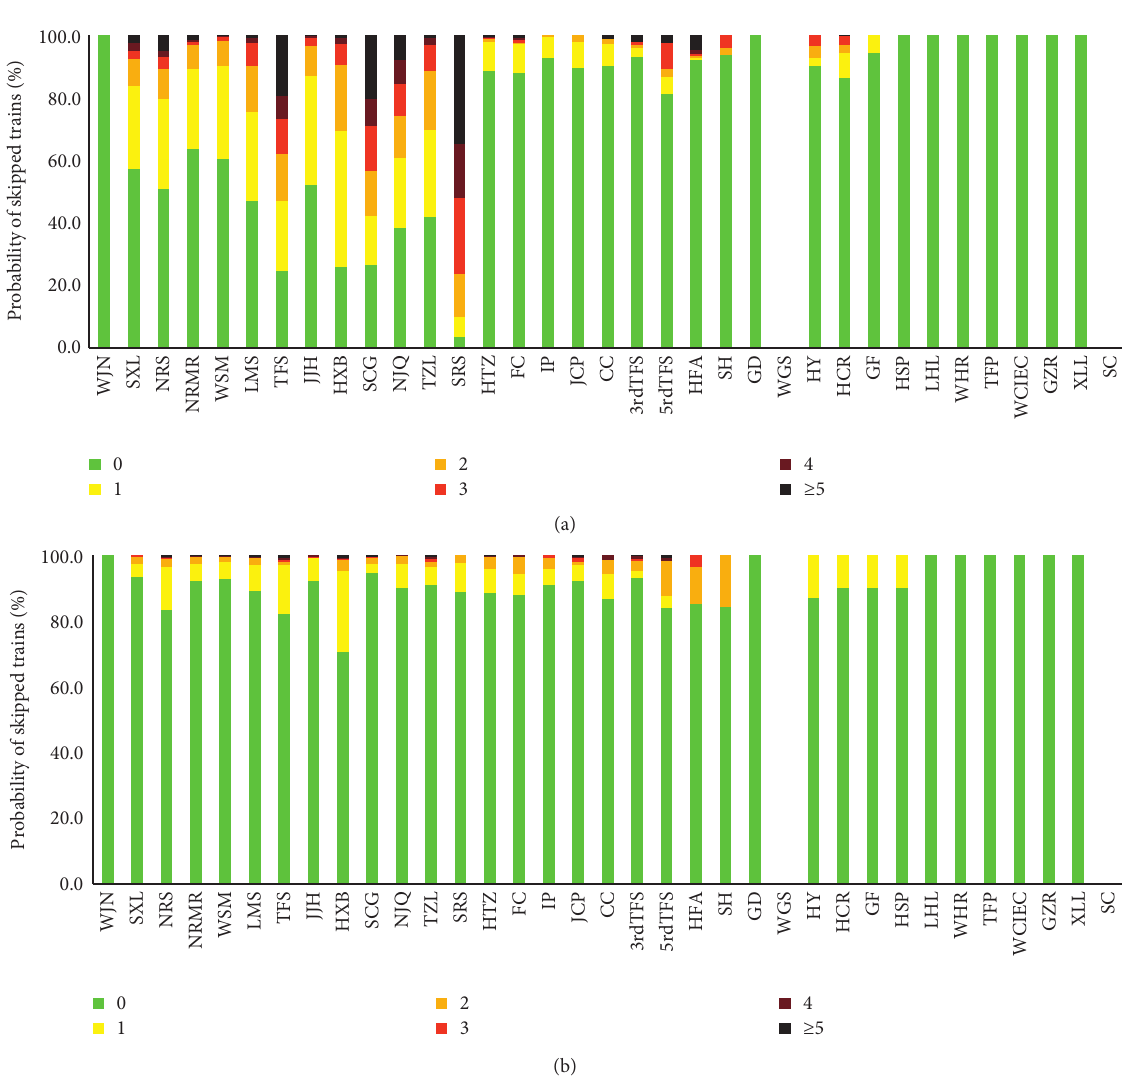
Figure 9: Probability of number of skipped trains by passengers on line 1 (WJN-SC). (a) AM peak. (b)